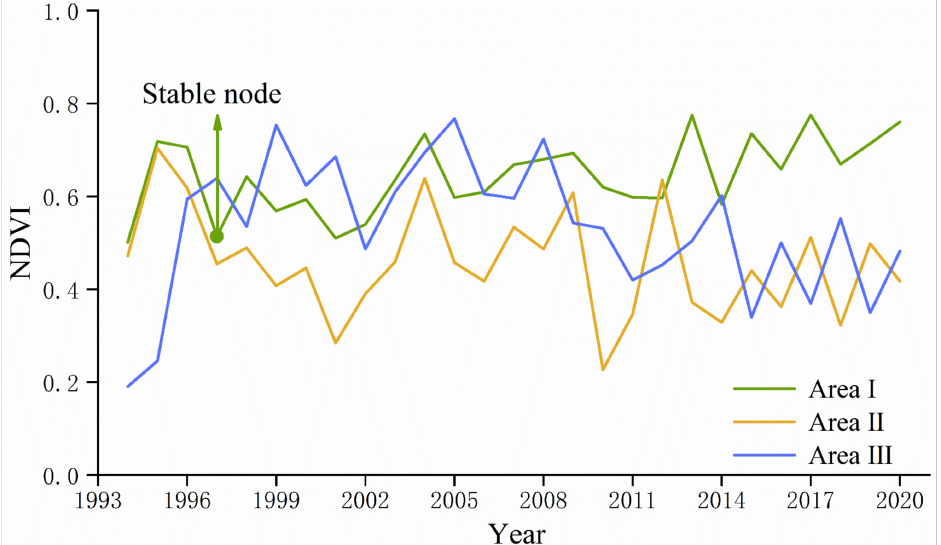
Figure 4. Annual average of NDVI in the “typical area” (area I) and the “problem areas” (areas II and